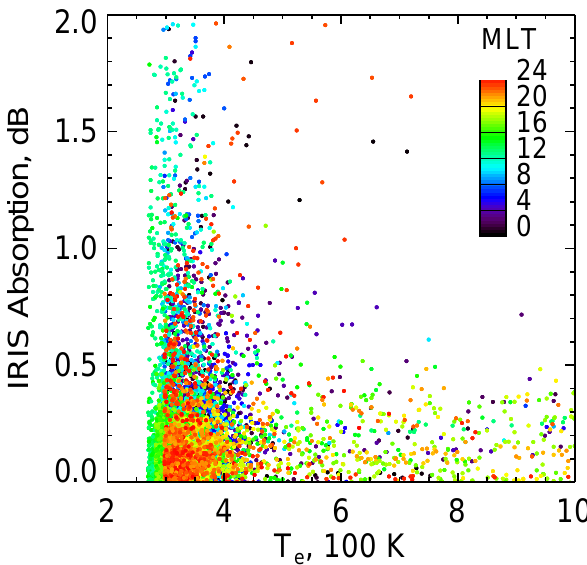
Fig. 10. Scatter plot of absorption versus the electron temperature colour-coded in MLT. The data in each MLT sector is restricted to include temperatures above the threshold electron temperature (see text for